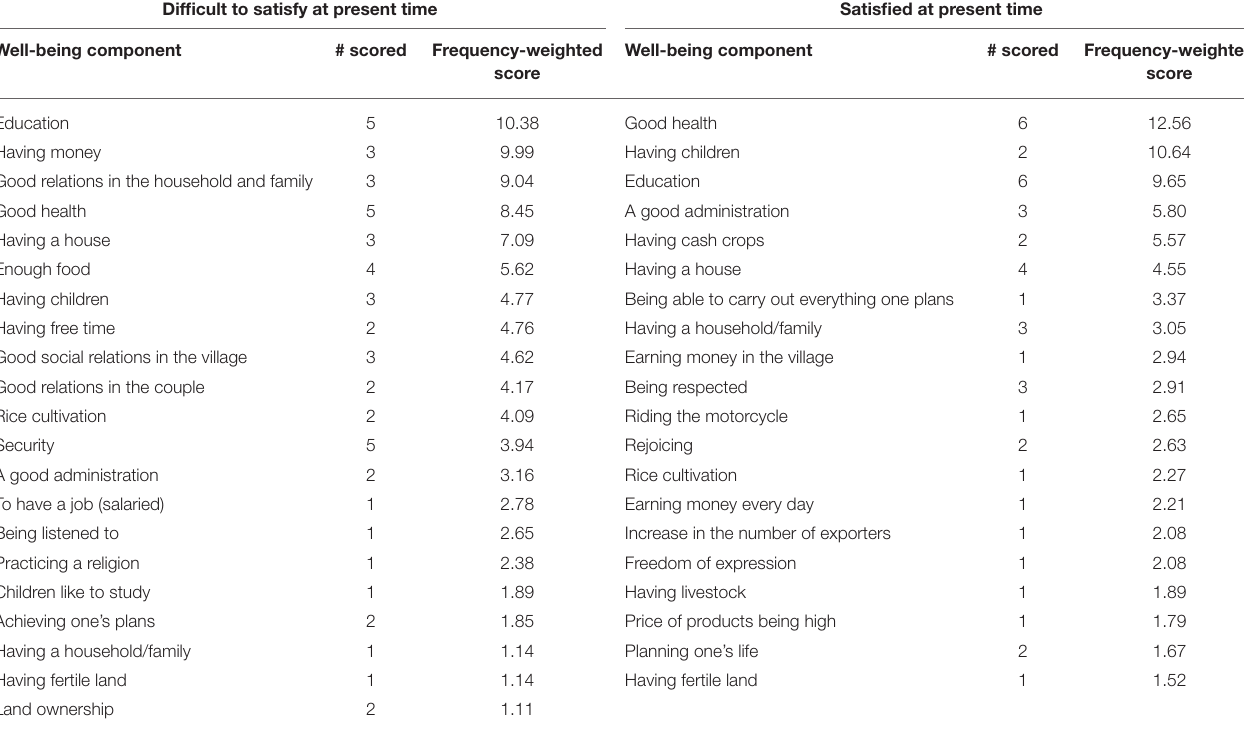
TABLE 4 | “Difficult to satisfy” and “satisfied” well-being components mentioned in the FGDs across the four villages and both genders. Difficult to satisfy at present